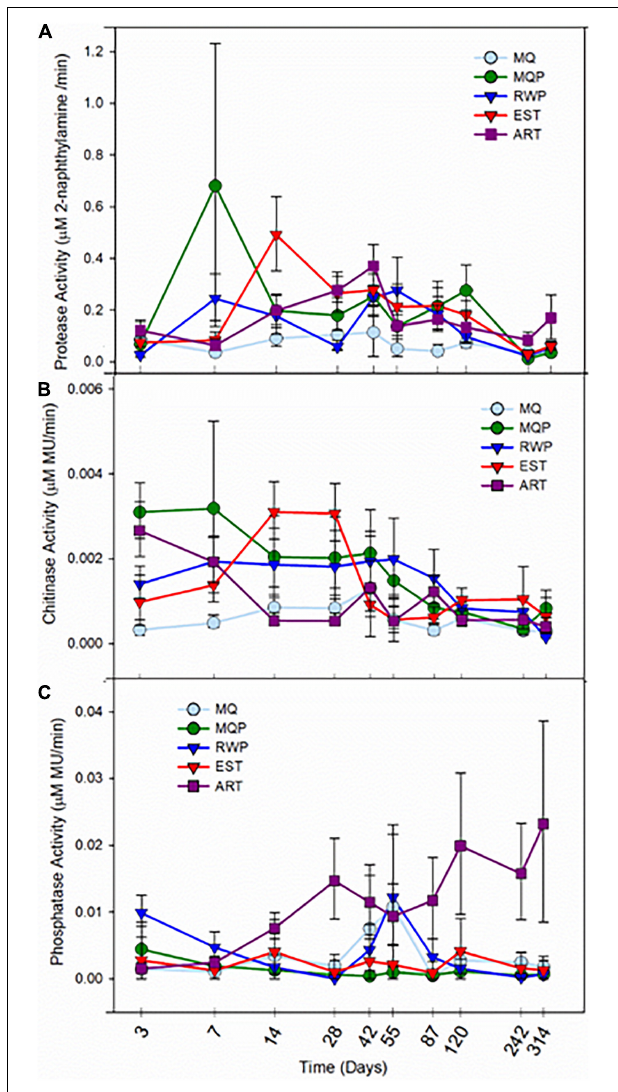
FIGURE 6 | Activity of hydrolytic enzymes protease (A) , chitinase (B) , and alkaline phosphatase (C) in pitcher fluid within five treatments (MQ, MQP, RWP, EST, and ART) sampled over 314 days from the start of the greenhouse experiment. Treatment abbreviations are the same as for Figure 1 . Points are means of values for seven replicate pitchers for each treatment and bars are standard error. The time axis is on a log